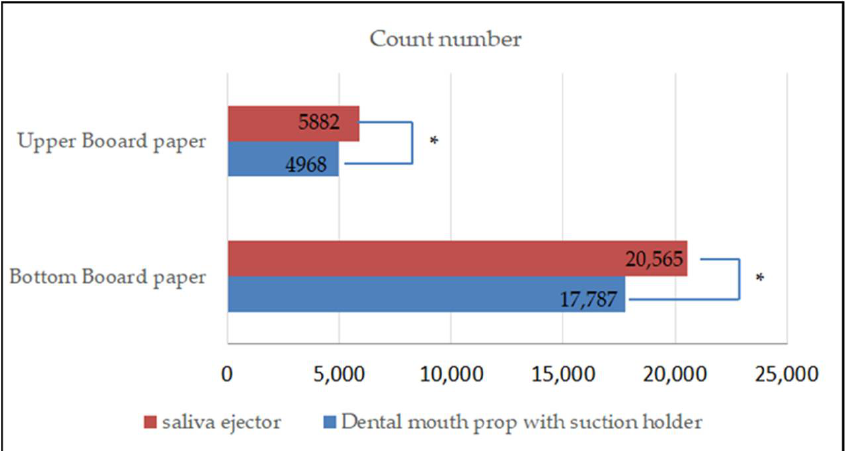
Figure 5. Bar chart showing the difference between the count number of aerosol and splatter particles between the upper board paper and bottom board paper. * Statistical significance at p < 0.01.